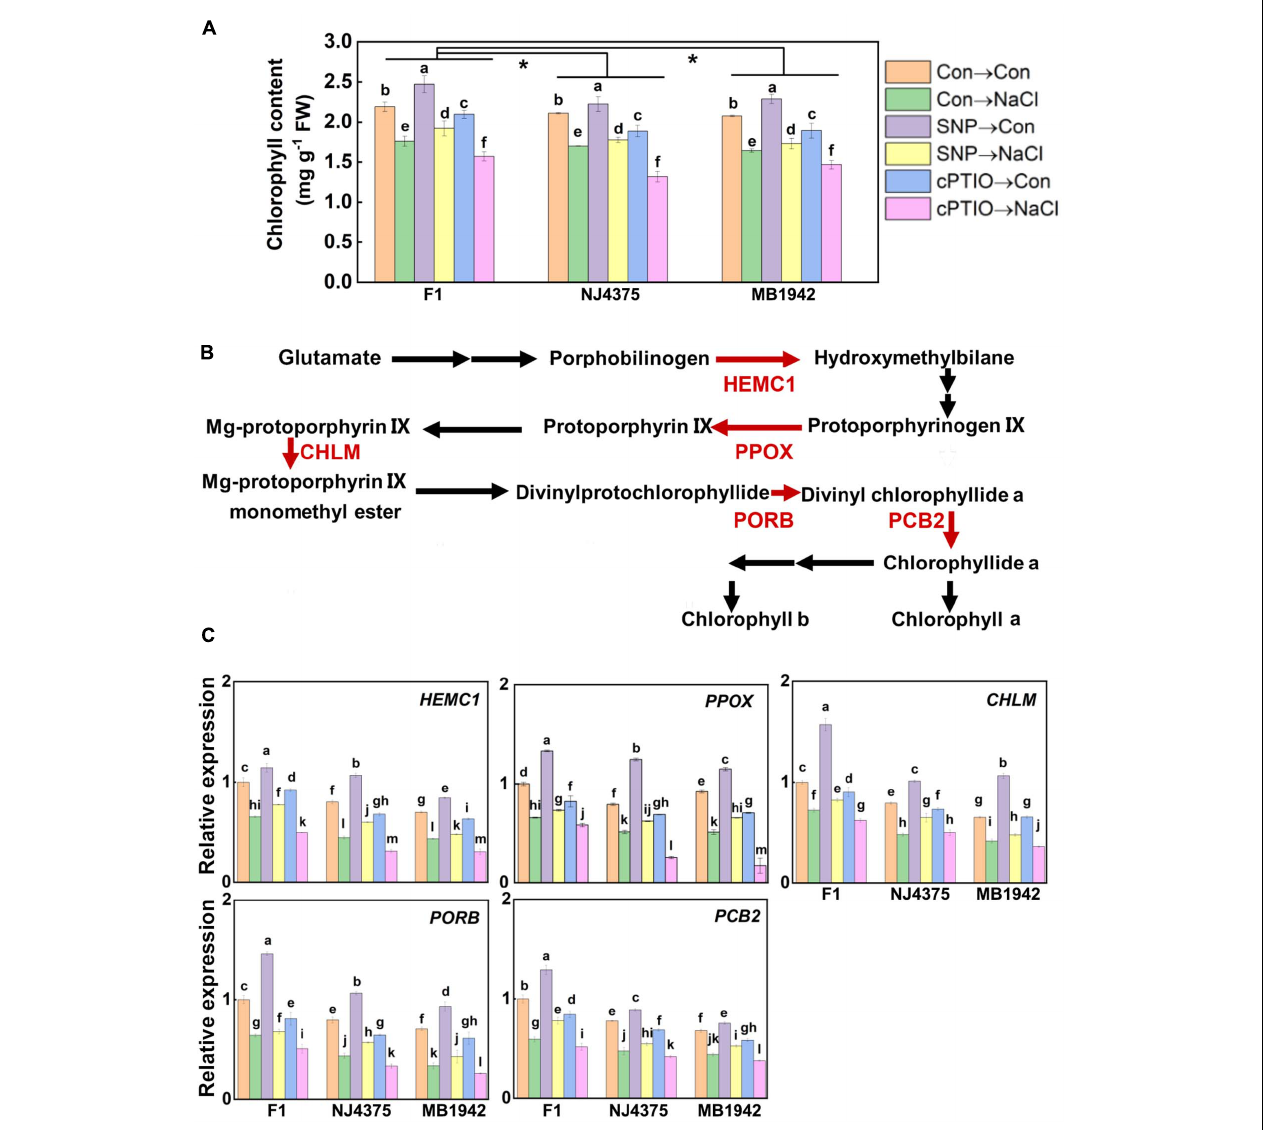
FIGURE 5 | The role of NO in the regulated chlorophyll metabolic process. (A) Chlorophyll content was detected after treatment for 14 days. (B) After stress for 3 days, the proteins were extracted from the leaf tissues. Chlorophyll metabolism-related proteins were identified by LC-MS/MS. Compared with the parental lines, the less pronounced decreased proteins associated with NO in the hybrid, including hydroxymethylbilane synthase (HEMC1), protoporphyrinogen/coproporphyrinogen III oxidase, (PPOX), magnesium-protoporphyrin O -methyltransferase (CHLM), protochlorophyllide reductase (PORB), and divinyl chlorophyllide-a 8-vinyl-reductase (PCB2), are shown in red (data obtained from Supplementary Table 2 ). (C) After treated for 1 day, the expression profiles of the corresponding genes in the leaves of F1 and two parents were analyzed by qPCR. Values are the means ± SD for three independent experiments. For panel (A) , bars with different letters represent significant differences among treatments in a genotype (one-way ANOVA, P < 0.05, Duncan’s multiple range test), and the asterisk indicates significant difference between genotype × treatment interactions (two-way ANOVA, P < 0.05, Student’s t test). For panel (C) , bars with different letters represent significant differences (one-way ANOVA, P < 0.05, Duncan’s multiple range test).